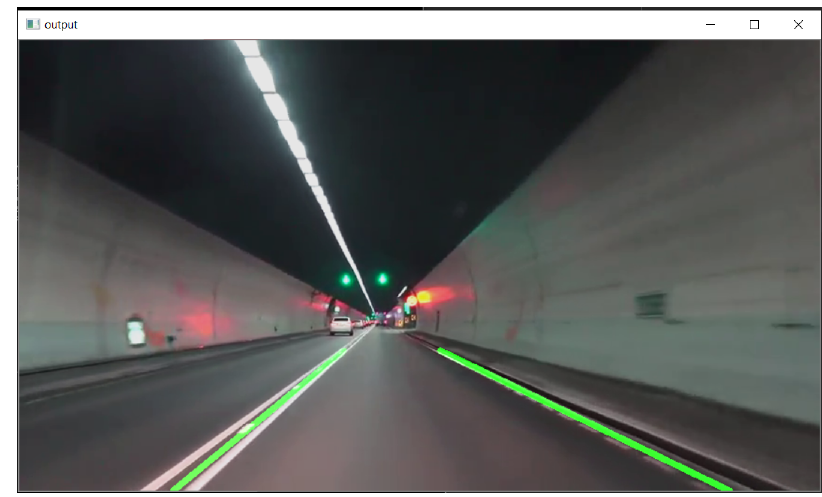
Figure 4. Final output of the Lane Detection